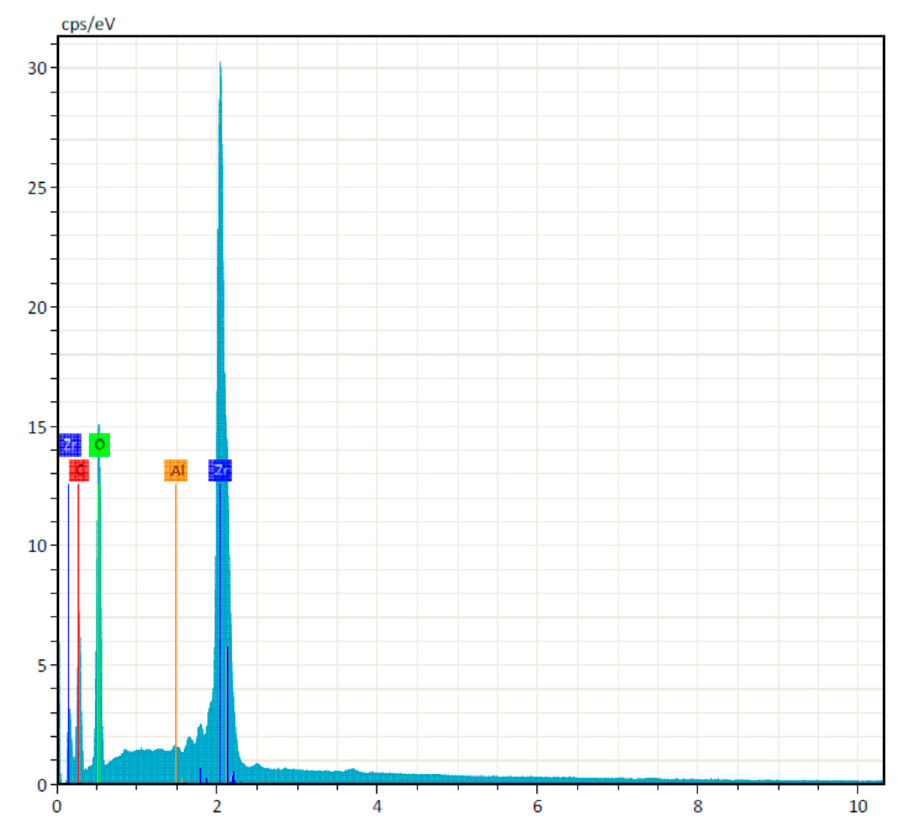
Figure 7. T he spectroscopic analysis of the new zirconia drill surface showed that the flat area of implant drills was mainly composed of zirconia.